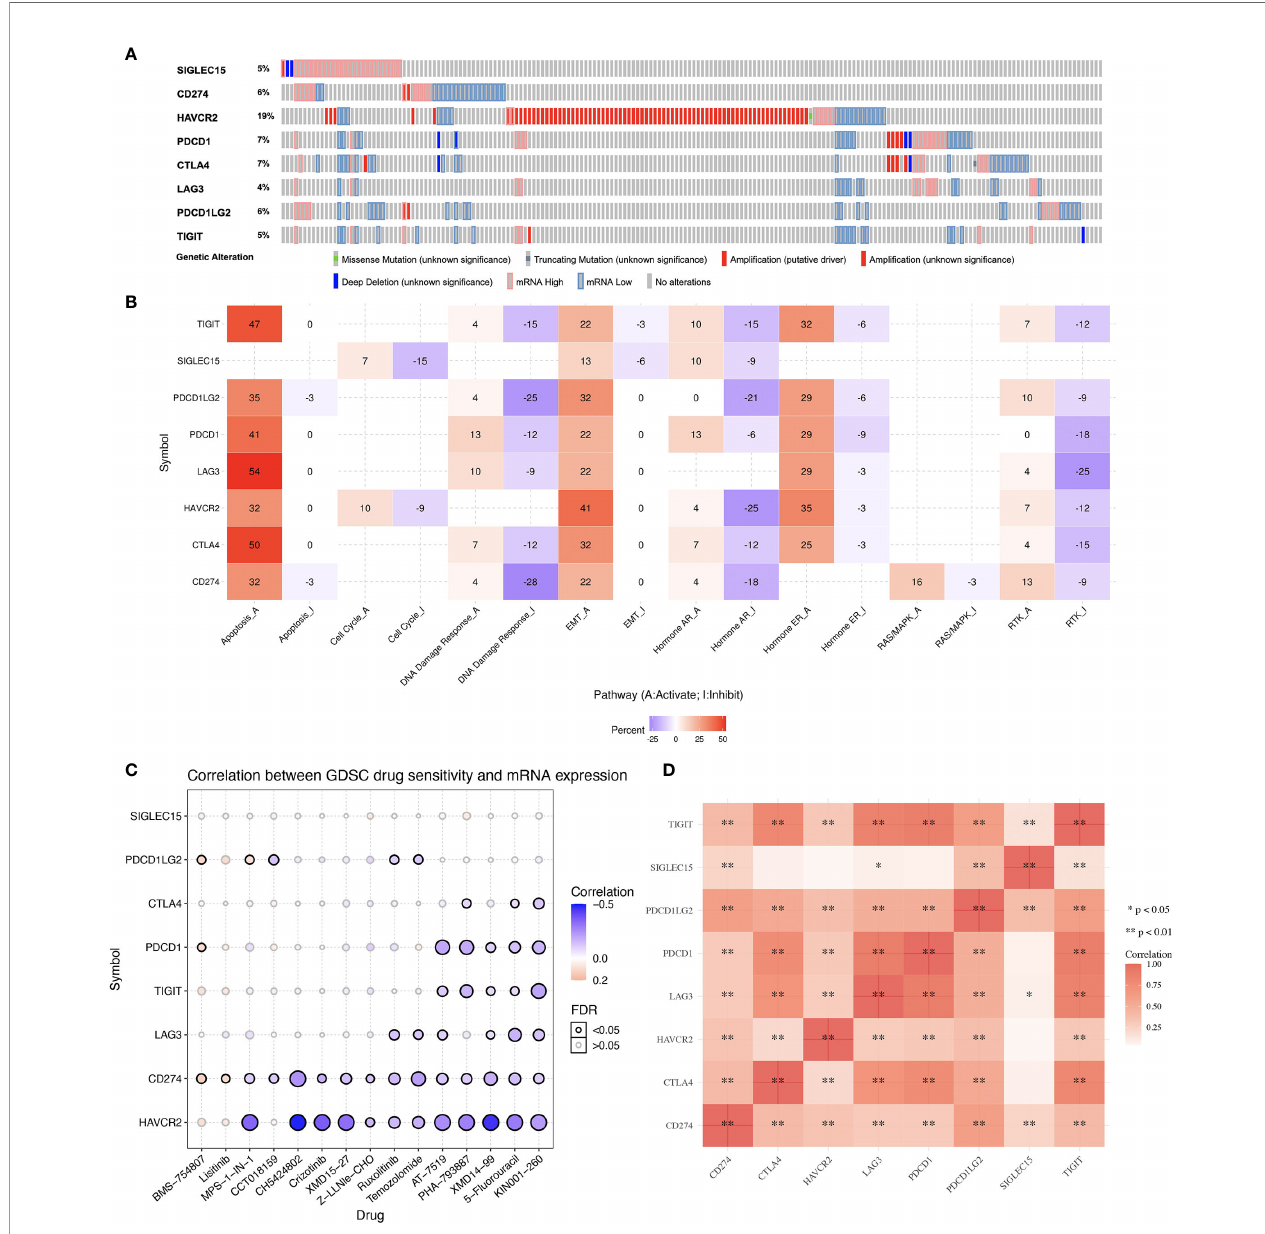
FIGURE 2 | Genetic mutation landscape and drug sensitivity analysis of immune checkpoints in KIRC. (A) Oncoplot displaying genetic mutation landscape of immune checkpoints in TCGA KIRC cohort. (B) The activation and inhibition of immune checkpoints in KIRC-related pathways. (C) The correlation between immune checkpoints and drug or small molecules. The positive correlation means that the gene high expression is resistant to the drug, vise verse. (D) A heat map of the correlation between each member of immune